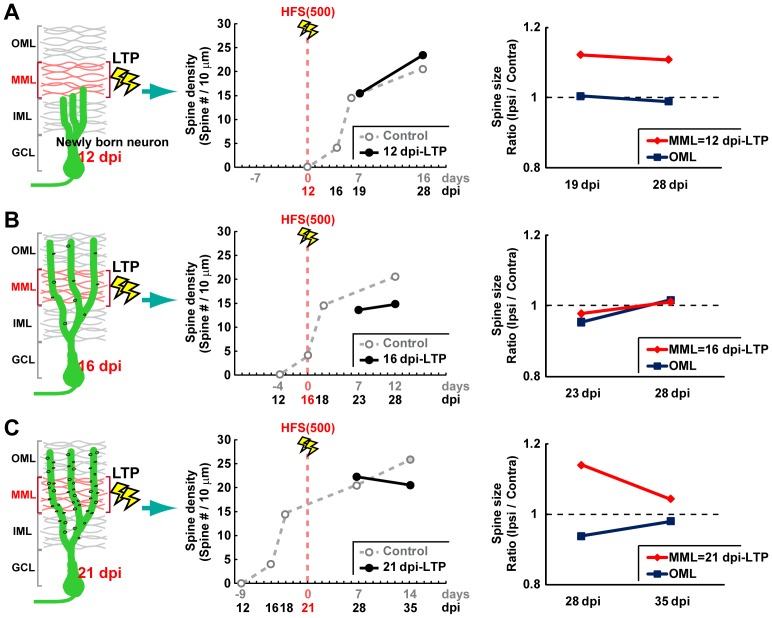
Formation of neural plasticity differentially regulates the integration of new neurons into the activated circuit.(A) LTP induction at the no-spine stage of new neurons (12 dpi) specifically increases their spine size and spine expression rate within the LTP-induced layer by 3 (19 dpi) and 4 weeks of neuronal age (28 dpi), respectively. (B) LTP induction at the time of initial spinogenesis of new neurons (16 dpi) locally inhibits the later expression of spines in an LTP-induced layer-specific manner. (C) LTP induction after the drastic spinogenesis stage of new neurons, at 21 dpi, induced their later spine enlargement in the LTP-induced layer at 28 dpi. The spine enlargement is return to basal level, and the later spinogenesis is inhibited by 35 dpi. All LTP-mediated changes are tightly correlated with actual formation of the activity-dependent neural plasticity. Left, Schematic representation of morphology of each new neurons at 12, 16, or 21 days after birth ( = 12, 16, or 21 dpi, respectively). High frequency stimulation [HFS(500)] for LTP induction is specifically delivered at MML of ipsilateral hemisphere in all experiments of present study. Middle, The mean values of spine density at indicated timing under control and LTP-induced conditions are plotted by white (represented in Figure 1F) and black circles, respectively. Right, Graph shows the mean values of ipsilateral (Ipsi)/contralateral (Contra) ratio of spine cross-sectional area in MML and OML. Abbreviations: GCL, granule cell layer; IML, MML, and OML, inner, middle, and outer molecular layer, respectively.